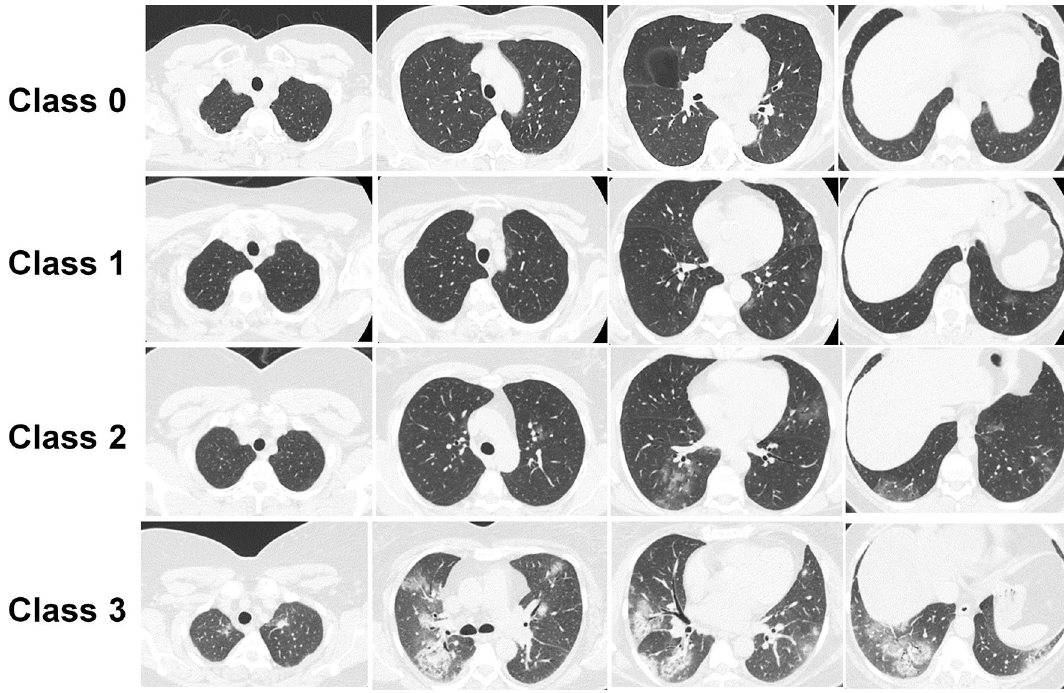
Figure 2. Examples of patient CT images belonging to different classes with different